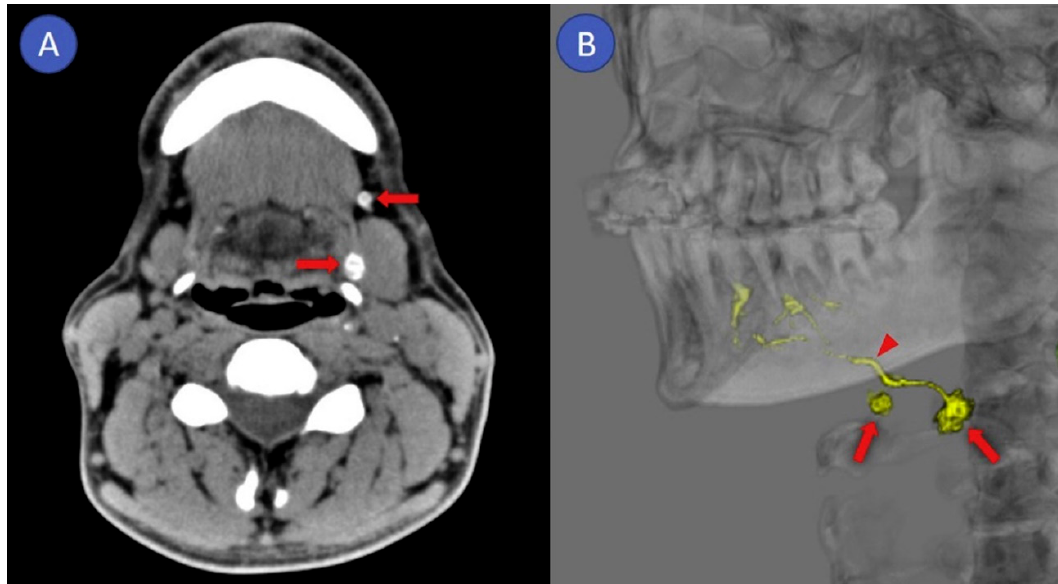
Figure 5. Computed tomographic lymphography: ( A ) axial image, ( B ) 3D image. Arrows: sentinel Computed tomographic lymphography: ( A ) axial image, ( B ) 3D image. lymph node; arrowhead: lymphatics [27]. Figure used with permission of Elsevier©, permission license number: 4807630528815 .